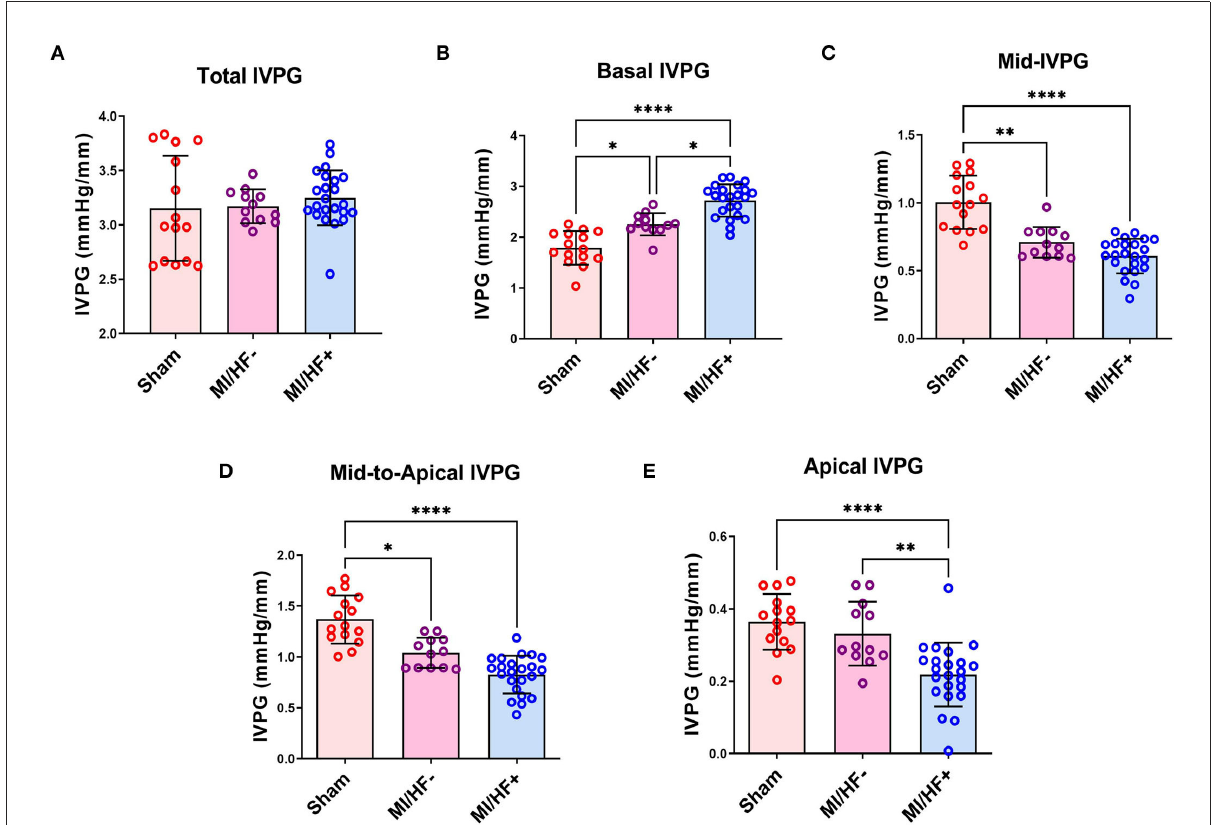
FIGURE3 Scatter plots with bars of the IVPG indices in different groups. Data presented as mean ± SD. The total IVPG showed no significant change among different study groups (A) . Basal IVPG was significantly increased in MI/HF– and MI/HF + groups compared to the Sham one (B) . The mid-IVPG (C) and the mid-to-apical IVPG (D) presented a significant decline in MI/HF– and MI/HF + groups compared to the Sham group. The apical IVPG decreased significantly in the MI/HF + group compared to the other groups (E) . * p < 0.05, ** p < 0.01, and **** p <